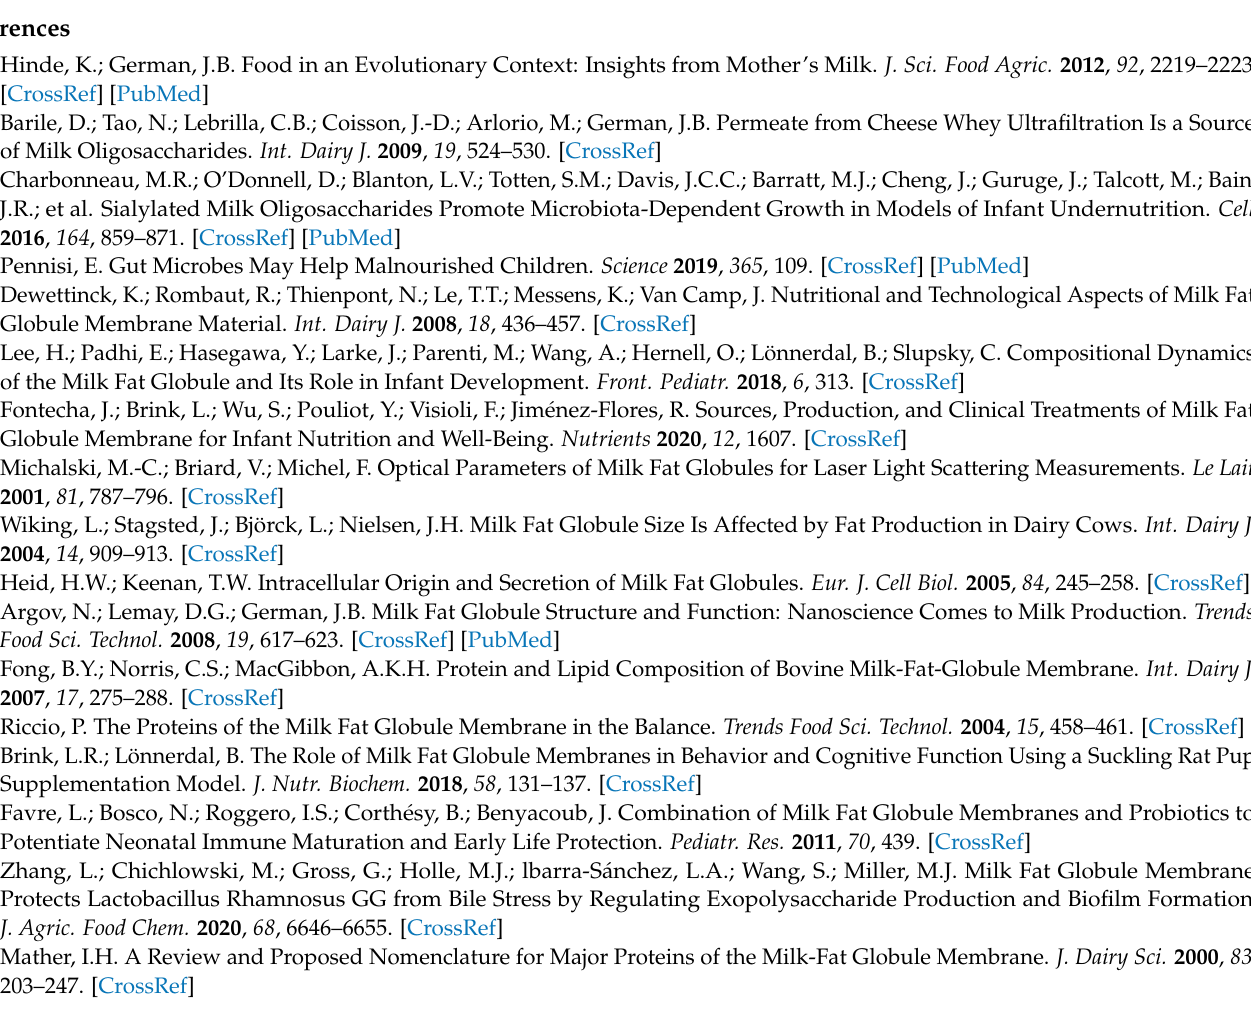
Table S2: Proteins identified in whey protein phospholipid concentrate (WPPC); Table S3: Fatty acid composition per lipid fraction (%) for sample